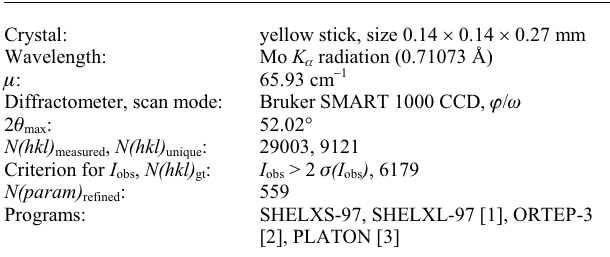
Table 1. Data collection and